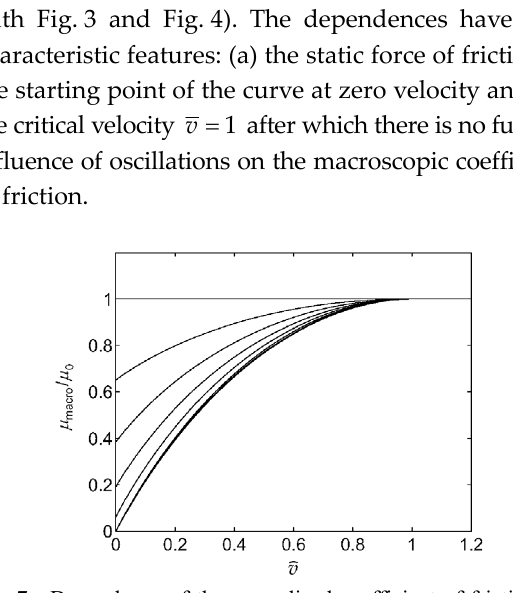
Fig. 7 Dependence of the normalized coefficient of friction on the normalized velocity v defined by Eq. (3) for the oscillation amplitudes / 0, 0.2, 0.4, 0.6, 0.8, 1.0 u u   (top to ,0 z z